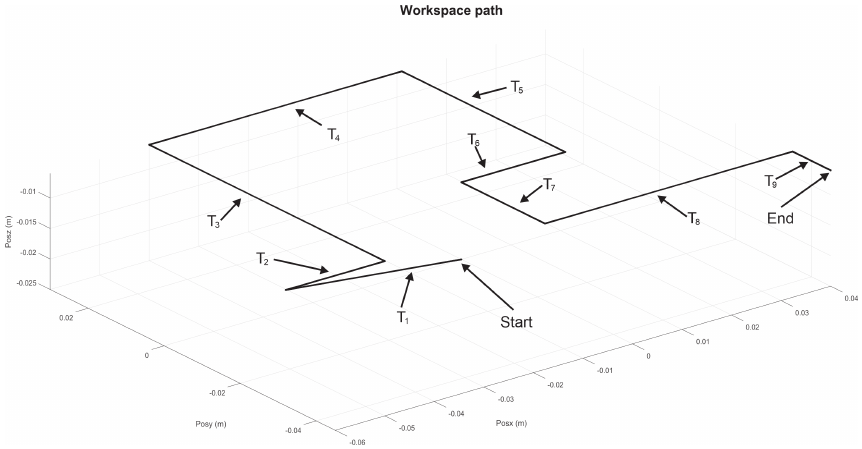
Figure 10. Composite task from T i trajectories for left haptic device for MCM test. Now, 20 via points are considered, for i = 19 transects T i , starting at P 1, see Figures 12 and 13 for right and left haptic devices, respectively.